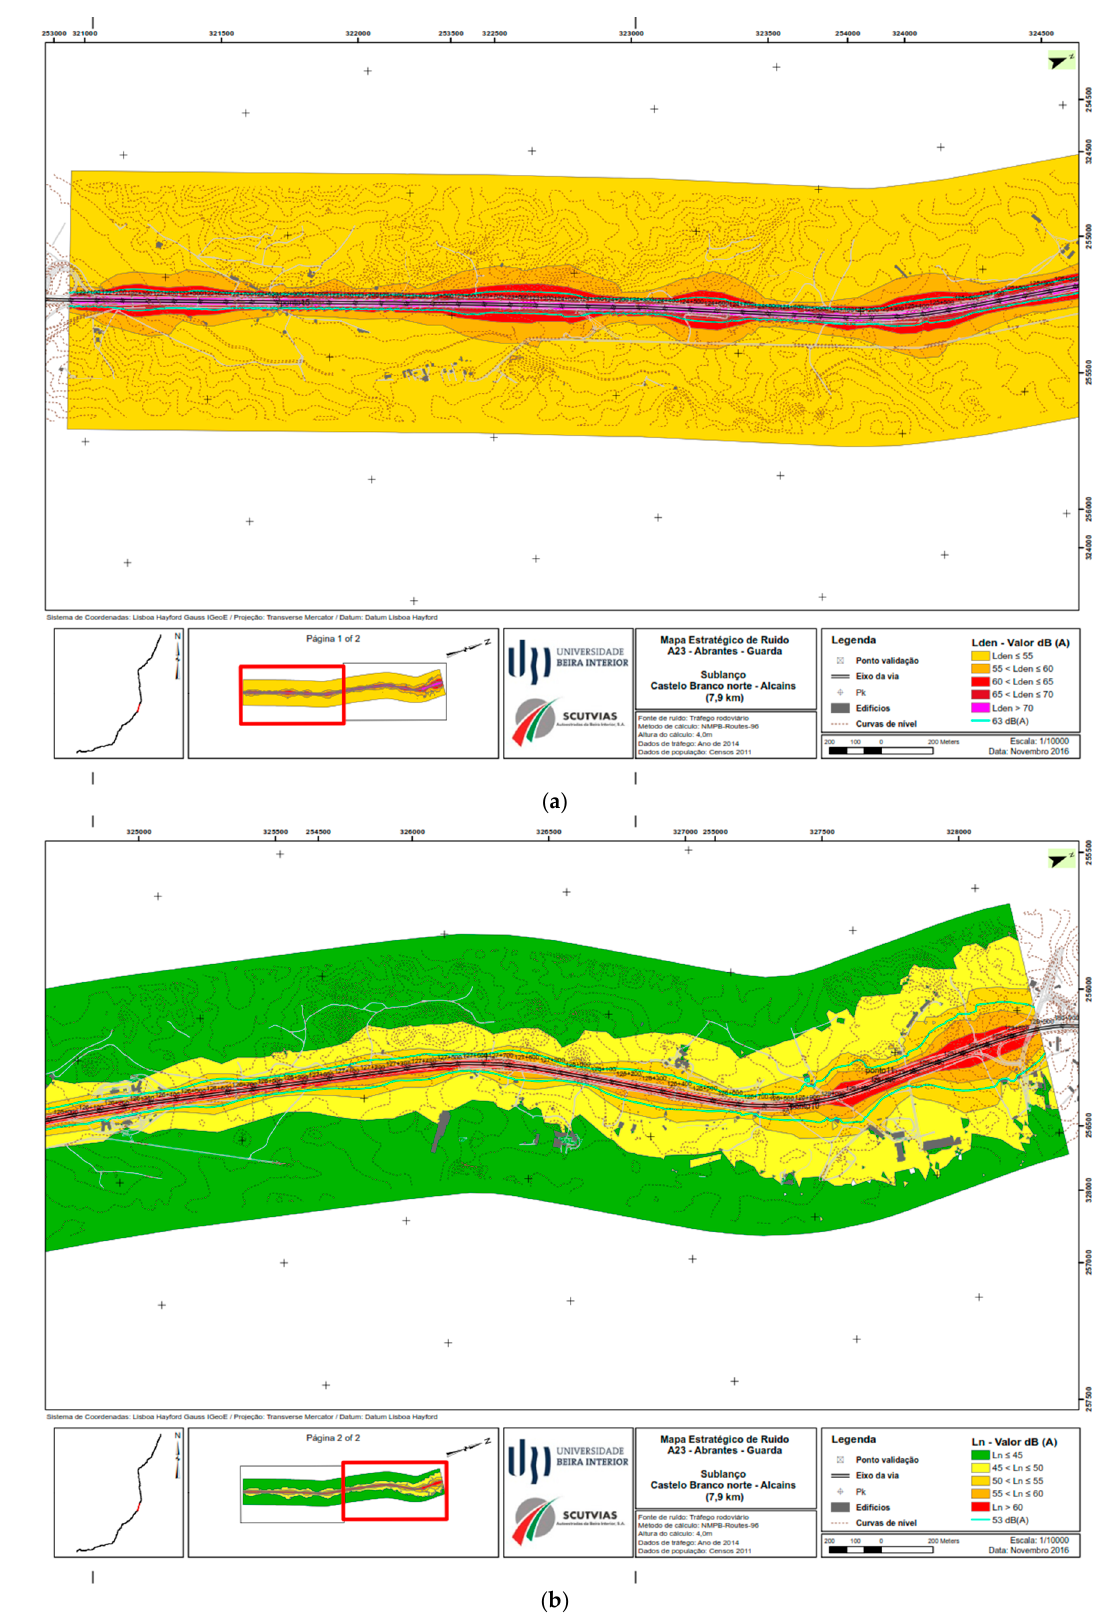
Figure 1. ( a ) Example of noise levels map to the (cid:1838) (cid:3019)(cid:3031)(cid:3032)(cid:3041) indicator; ( b ) noise levels map to the (cid:1838) (cid:3019)(cid:3041)